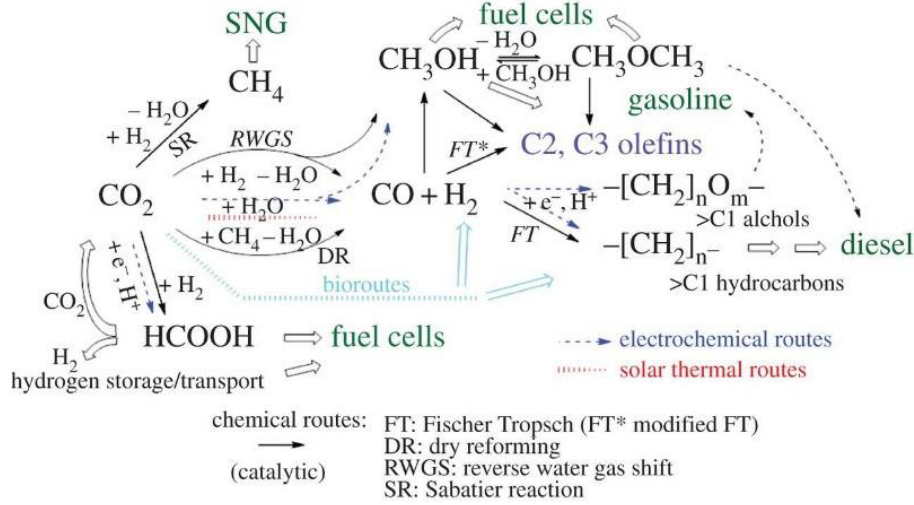
Figure 11. Possible routes for CO 2 hydrogenation with the incorporation of RE in the process. Reproduced with permission from [187], Royal Society of Chemistry, 2015.